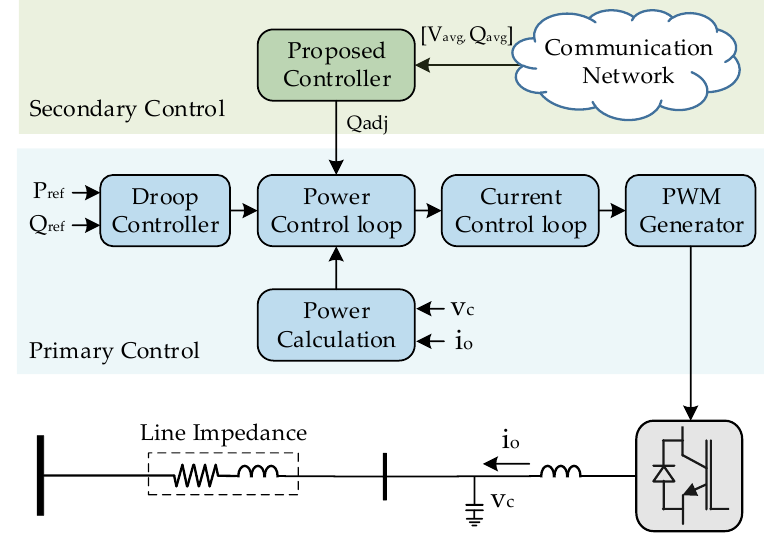
Figure 3. Distributed control for LVRT operation.